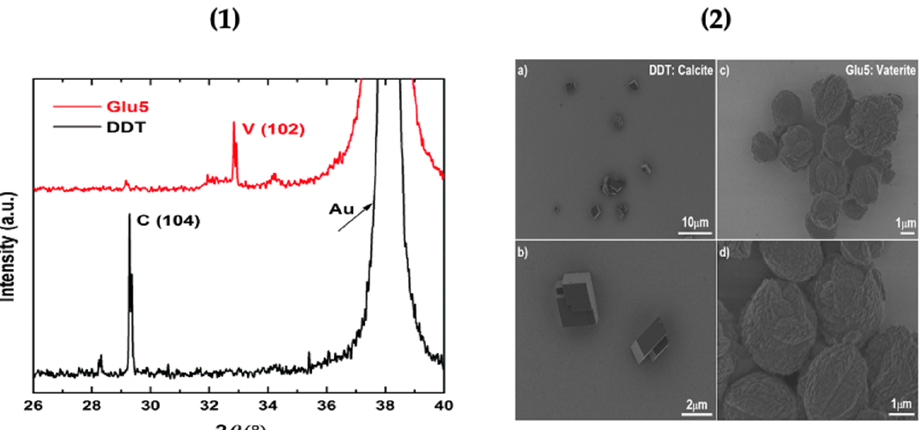
Figure 2. ( 1 ) XRD pattern of calcium carbonate formed on Glu5 peptide (red) and DDT (black) monolayers on Au substrate. (V) Vaterite; (C) Calcite. ( 2 ) SEM images of calcium carbonate polymorphs formed on DDT: calcite ( a , b ) and Glu5 peptide monolayers: vaterite ( c , d ) on Au. This Figure is adapted with permission from [31].